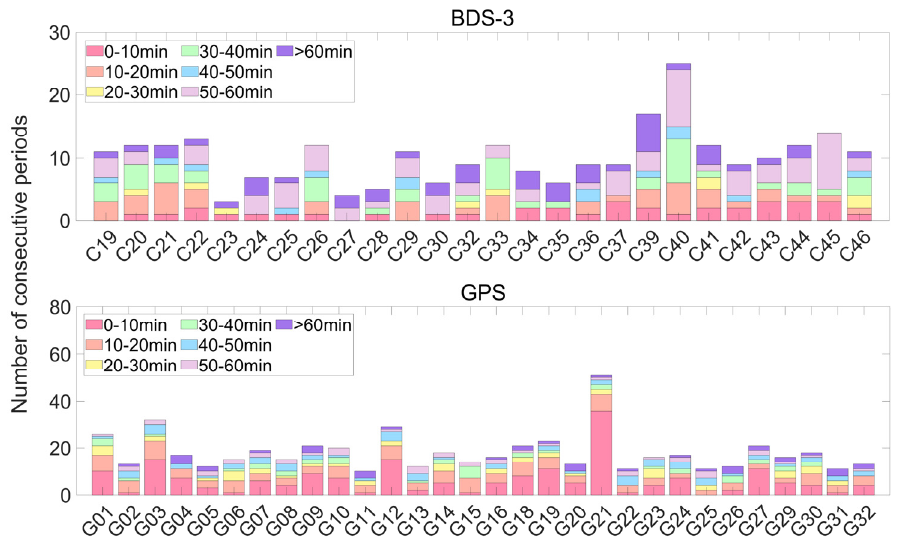
Figure 3. Number of consecutive periods for orbit arcs of the BDS-3 and the GPS satellites with different lengths of time on DOY 192 in 2022. Different colors represent different continuous time periods.